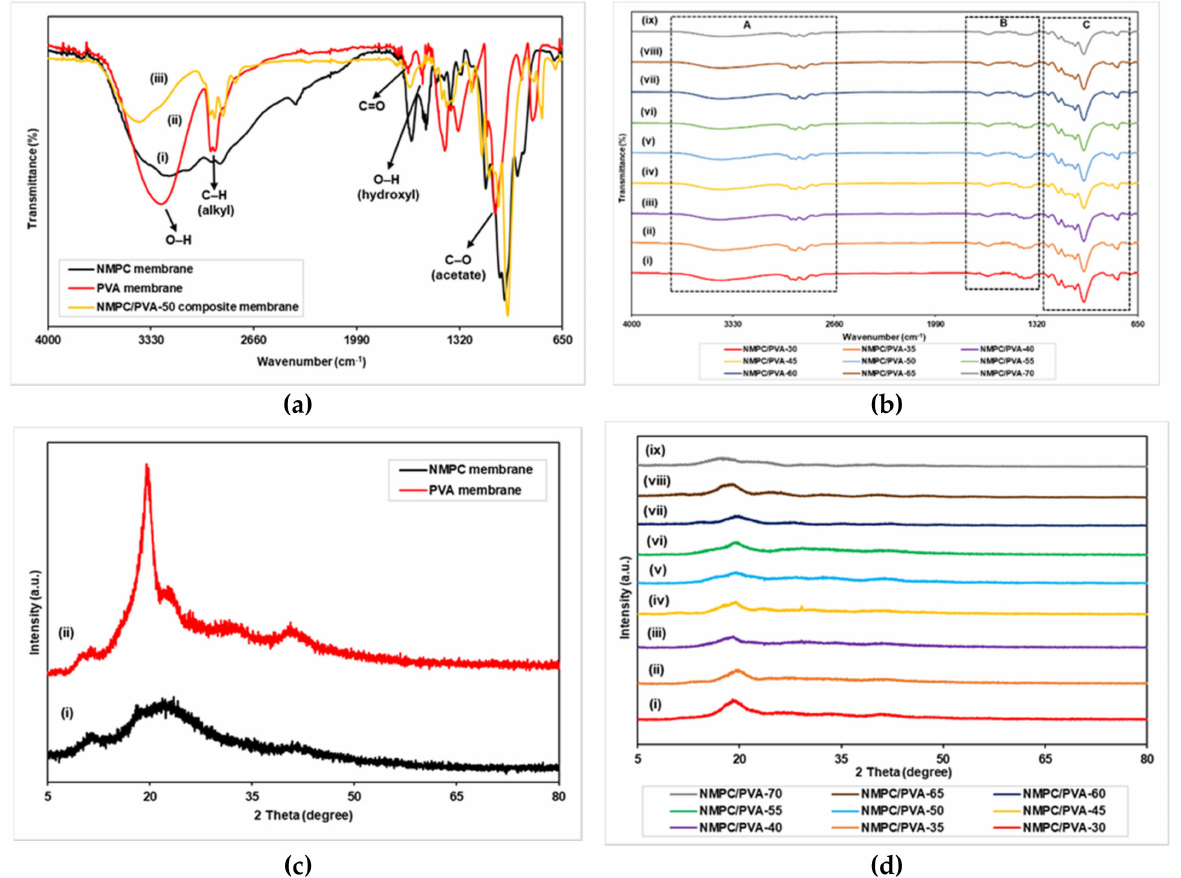
Figure 2. ( a ) FTIR spectra of NMPC membrane, PVA membrane, and NMPC/PVA-50 composite membrane, ( b ) FTIR spectra of NMPC/PVA composite membranes with different compositions, ( c ) XRD spectra of NMPC and PVA membrane, and ( d ) XRD spectra of NMPC/PVA composite membranes with different